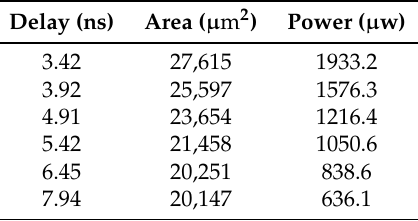
(c) Architecture of Figure 2b with p =